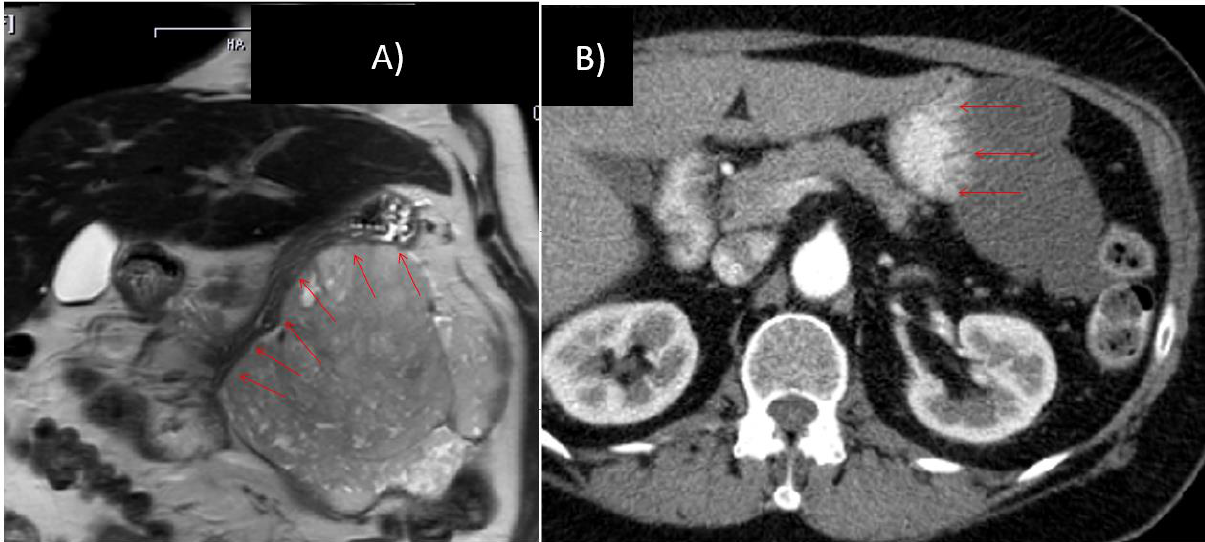
Figure 3. 76 year old female, gastrointestinal stromal tumors (GIST) with broad contact to the greater curvature, scheduled for total gastrectomy, left hemicolectomy and left-sided pancreatico-/splenectomy ( A ) prior to and ( B ) after 10 months of imatinib therapy.